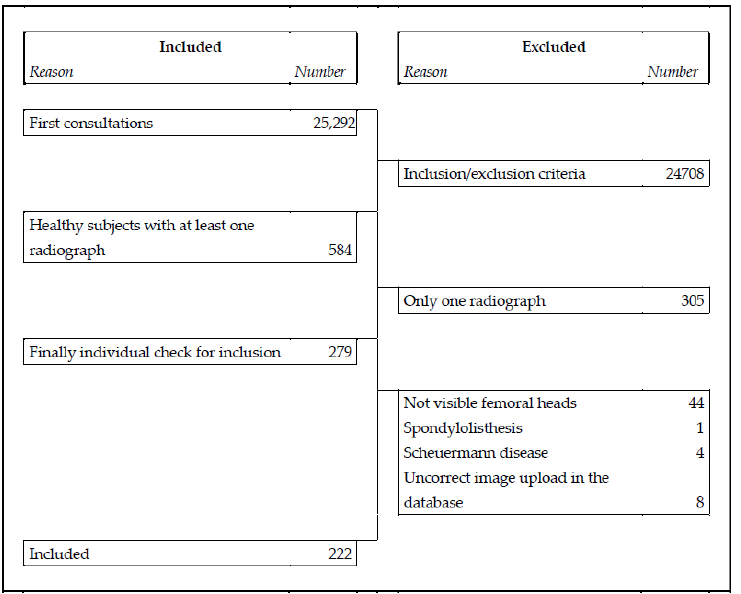
Figure 1. Flow chart of the procedure used to identify the study group of normal healthy individuals from the prospective database. We divided the patients into four age groups, and we found some statistically, but not clinically, significant differences between the sexes and among age groups (Table 1). Table 1. Characteristics of the study population according to gender and age groups.